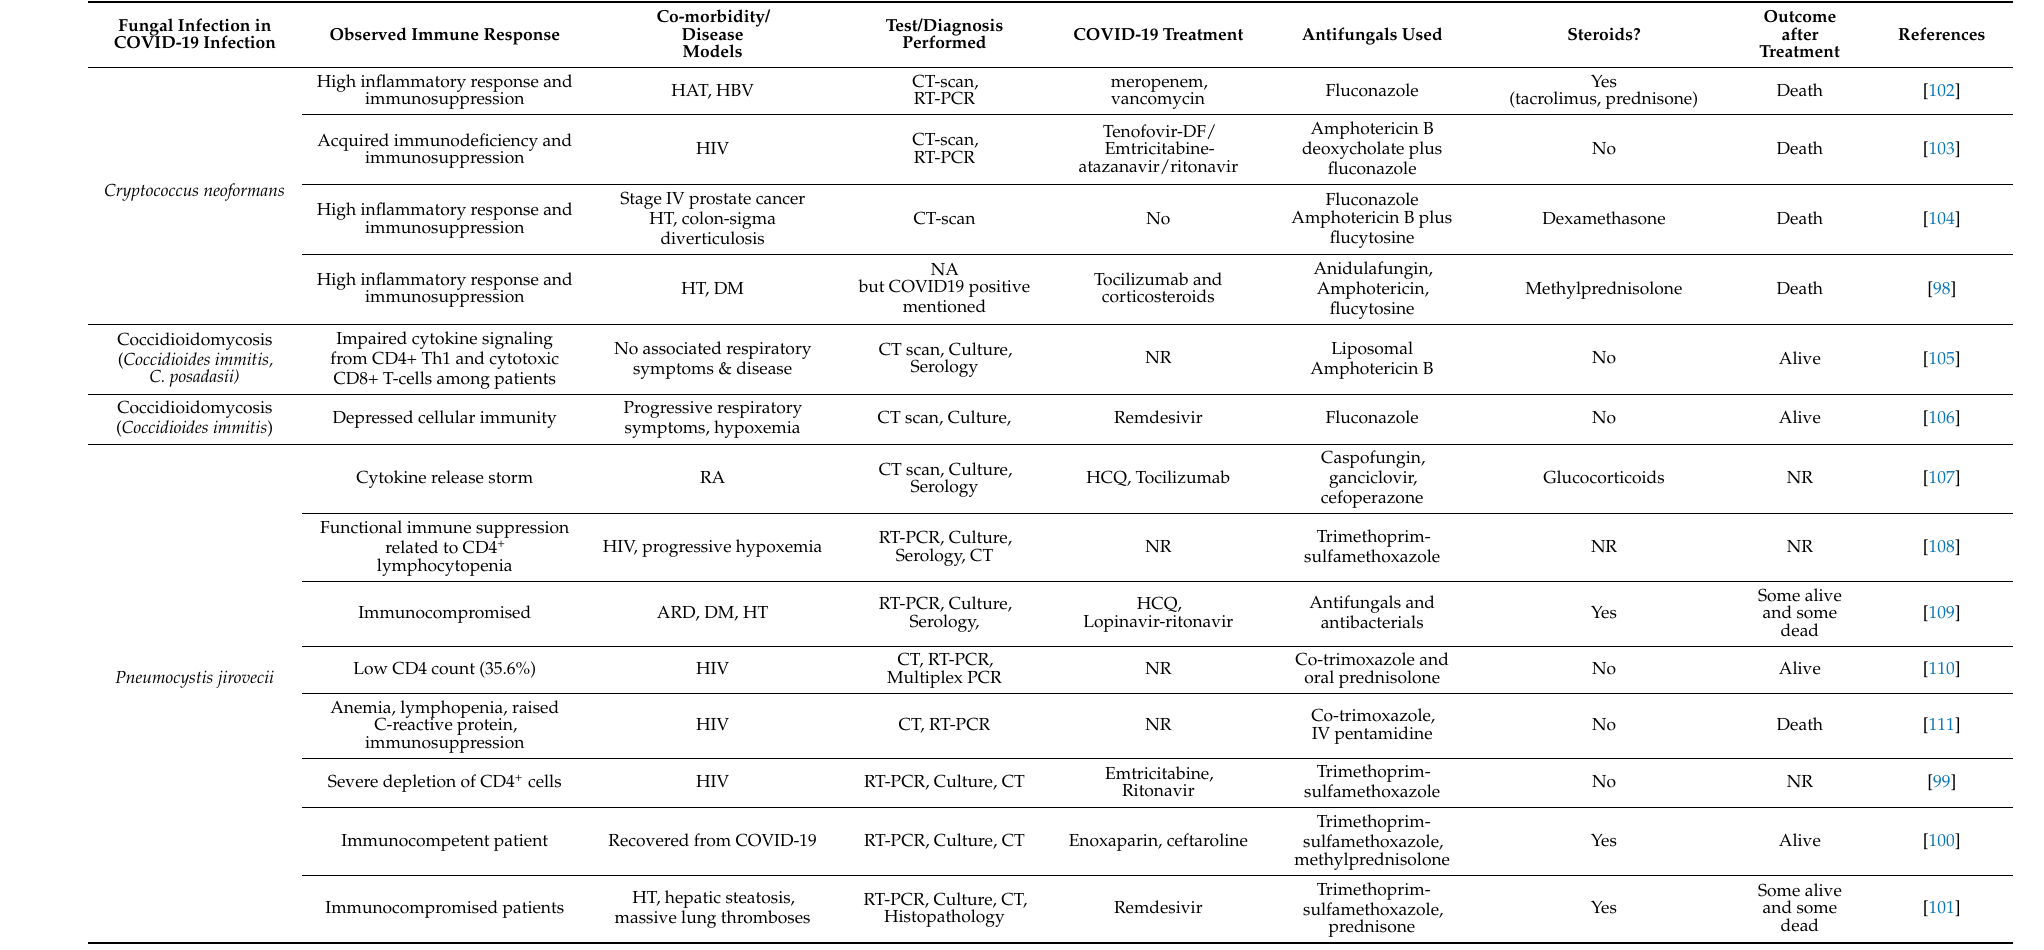
Table 5. Clinical characteristics of COVID-19 patients reported with cryptococcosis and other fungal